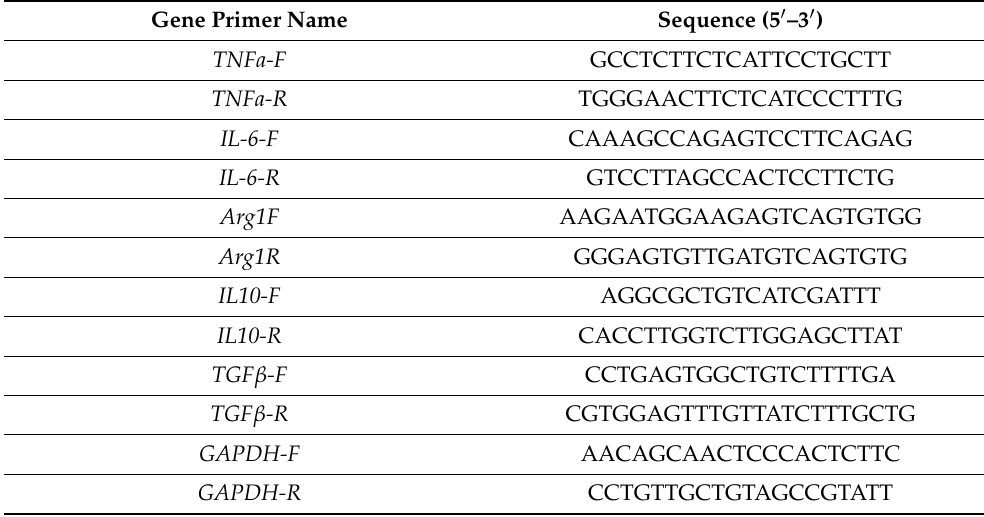
Table 1. Primer sequences used in this